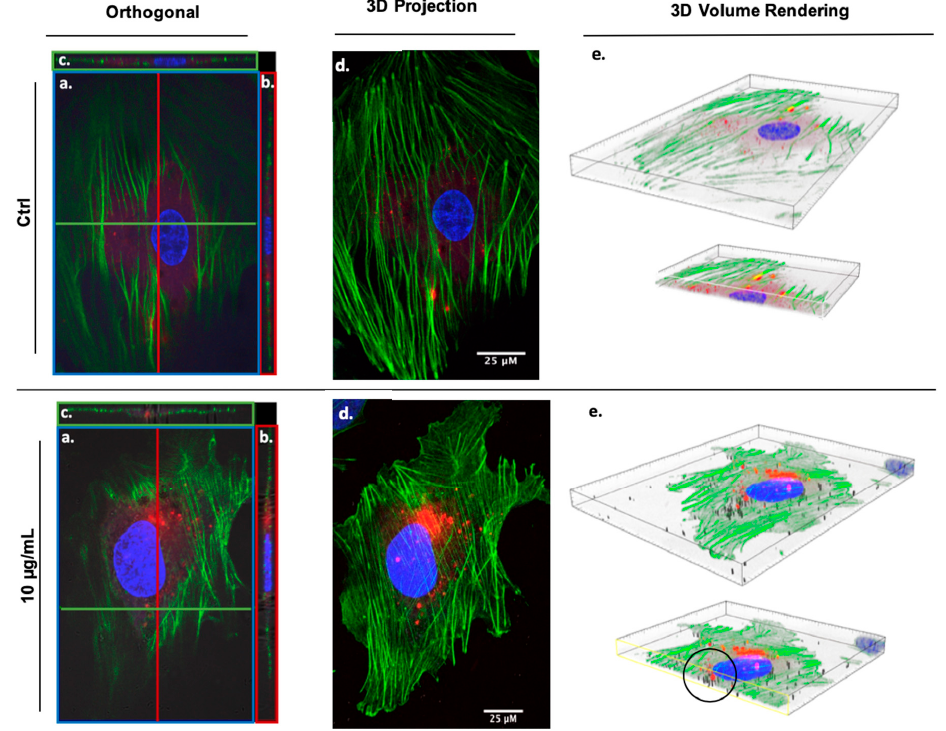
Figure 7. Z-stack images showing nanoMIL-89 uptake in PAECs. Orthogonal and 3D projections of Z-stack images of pre-stained PAECs showing: Untreated (control) PAECs and PAECs treated with 10 µg/mL nanoMIL-89. Projections are: ( a ) Transverse (xz, blue), ( b ) Sagittal (yz, red), ( c ) Frontal (xy, green), ( d ) 3D projection of Z-stack images and ( e ) 3D volume rendering of a single cell with a sliced view showing the cell content. Channels used—Red: CellTrackerTM Red CMTPX Dye, Green: phalloidin, Blue: diamidino-2-phenylindole (DAPI), and phase contrast: nanoMIL-89. Images indicate that nanoMIL-89 are internalized within the cytoplasm of the cells (black circle). Scale bar is 25 µm.